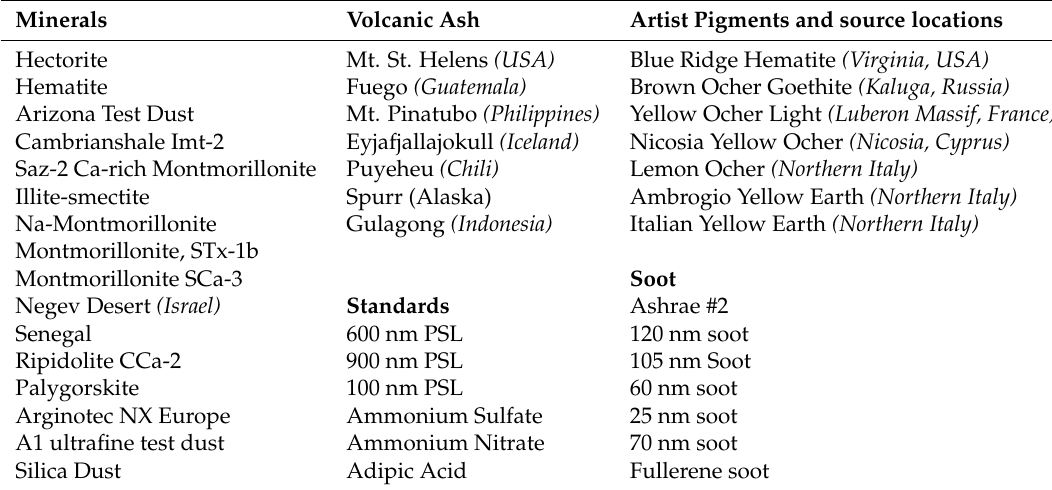
Figure 2. Circles indicate GRASP residuals σ as a function of extinction for 195 successful PI-Neph measurements (using PSAP absorption measurements and a simulated solar zenith angle of 50 ◦ ). The dashed line shows maximum residual allowed for Level 2 Aerosol Robotic Network (AERONET) retrievals (i.e., σ ≤ 8%). The bars indicate the percentage of retrievals that satisfy the σ ≤ 8% requirement in each extinction bin. Table 1. 285 different combinations of the following samples (internally and externally mixed), including humidified and dried runs of both PM 1 and PM 2.5